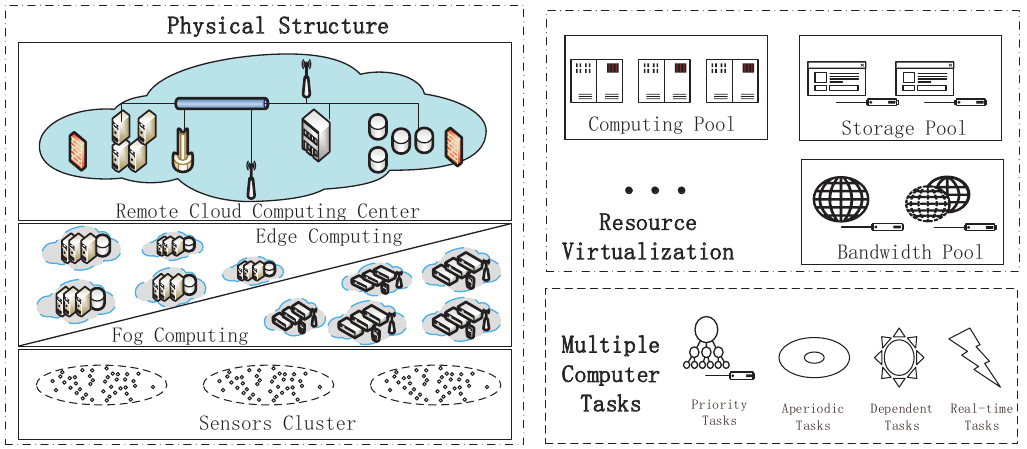
Figure 1. A schematic diagram of a cross-layer cloud computing